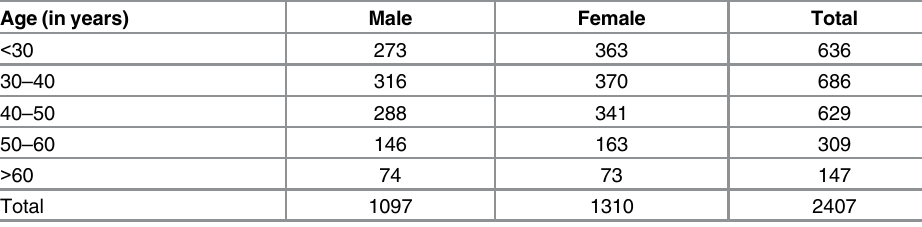
Table 2. The age distribution of the subjects included in the